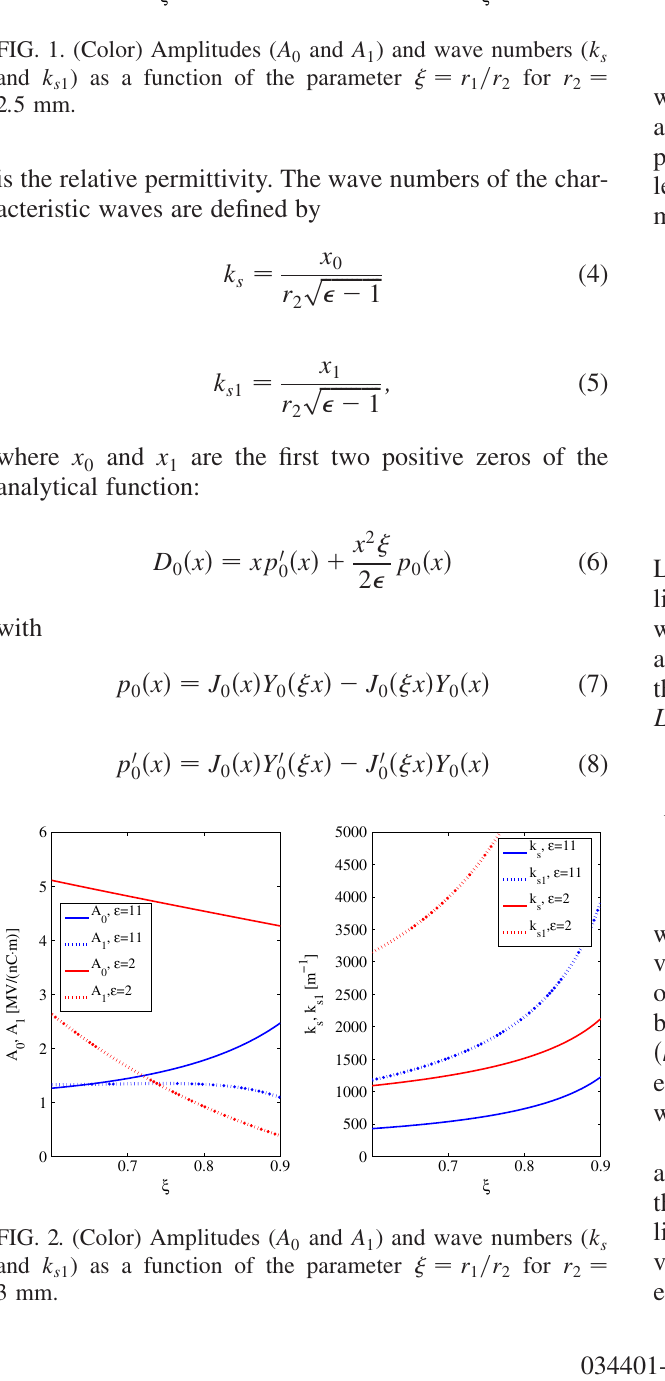
and A ) and wave numbers ( k s 0 1